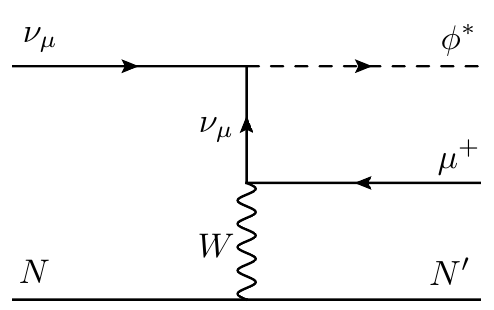
Figure 12.1: Example of the neutrino emission of φ before scattering off a nucleus, a “mono-neutrino” event that can be searched for in the DUNE near detector.